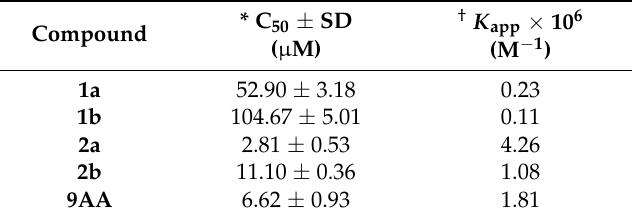
Table 1. C 50 and K app values for tested compounds.